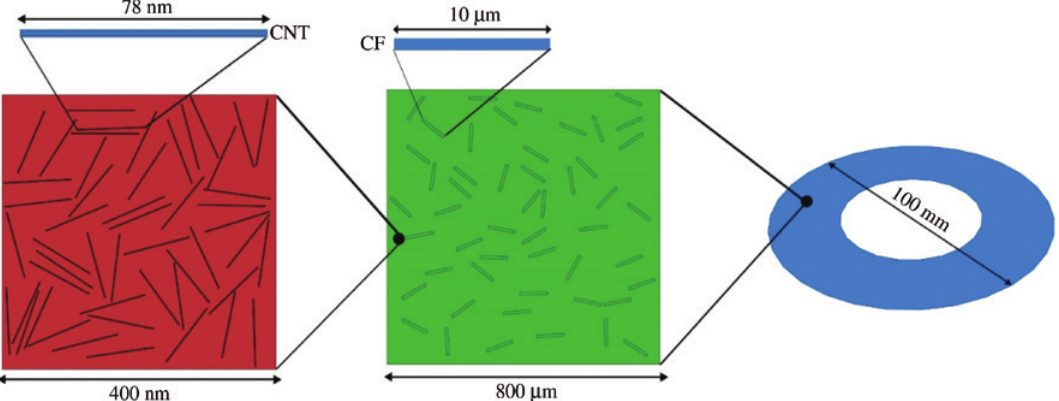
Figure 1: Multiscale modeling of CF-CNT-polymer hybrid annular composite plate.